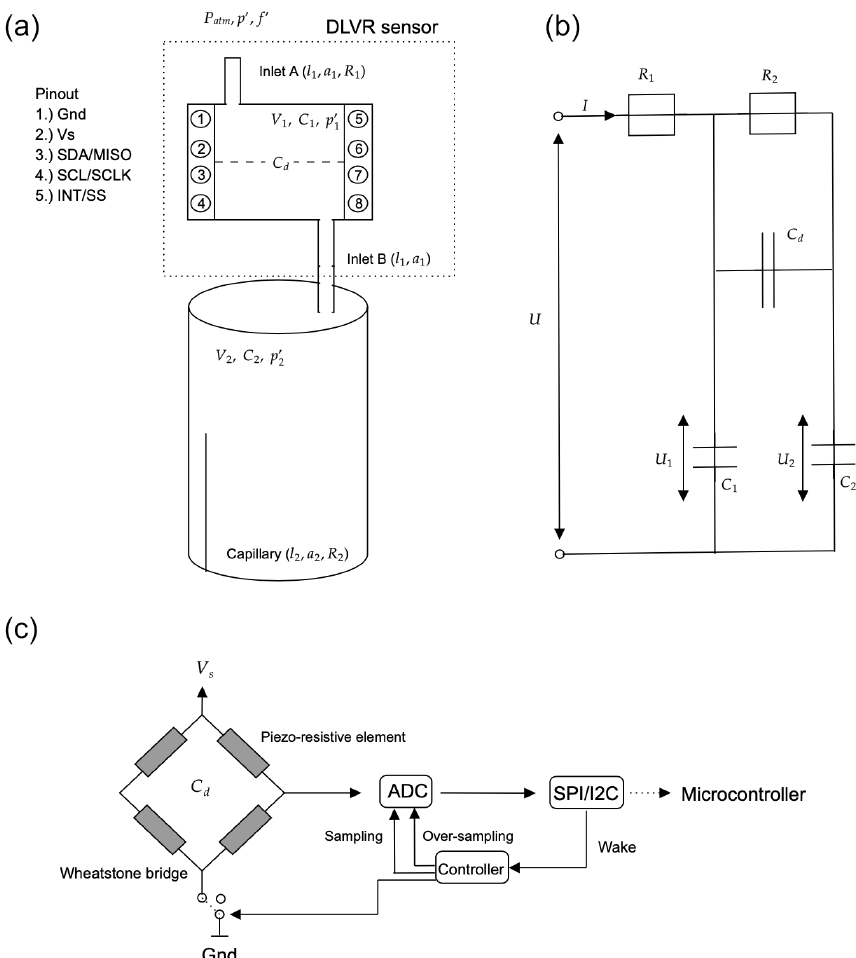
Figure 2. The KNMI mini-MB design with the DLVR sensor and the parameters as listed in Table 1 (a) and the electrical circuit of the mini-MB (b) . Panel (c) visualizes the DLVR